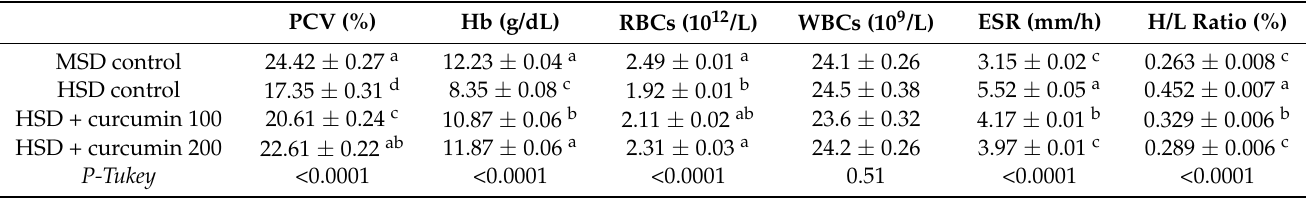
Table 5. Effect of curcumin on haematological parameters of broilers reared under high stocking density.